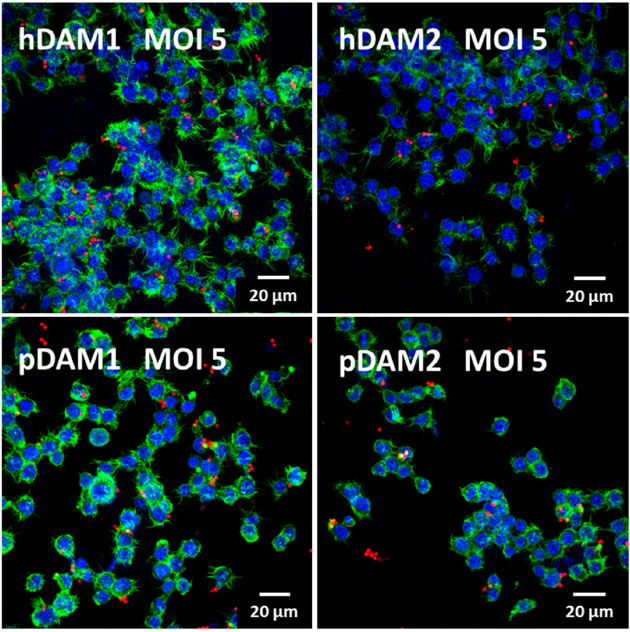
Figure 5. Confocal microscopy images of RFP- C. albicans (in red) ingested by RAW macrophages at MOI 5 after culture on human (h) and porcine (p) DAMs obtained by either enzymatic methods (hDAM1 and pDAM1) or treatment with organic solvents (hDAM2 and pDAM2). Nuclei were labeled in blue with 4 ′ ,6-diamidino-2-phenylindole (DAPI), and actin cytoskeleton were labeled in green with FITC-phalloidin.